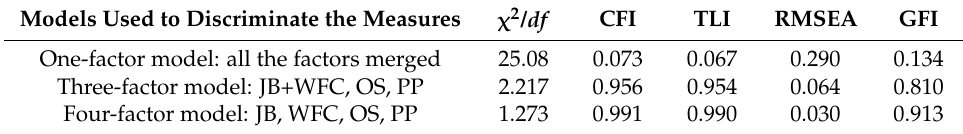
Table 5. The comparative results of alternative models.